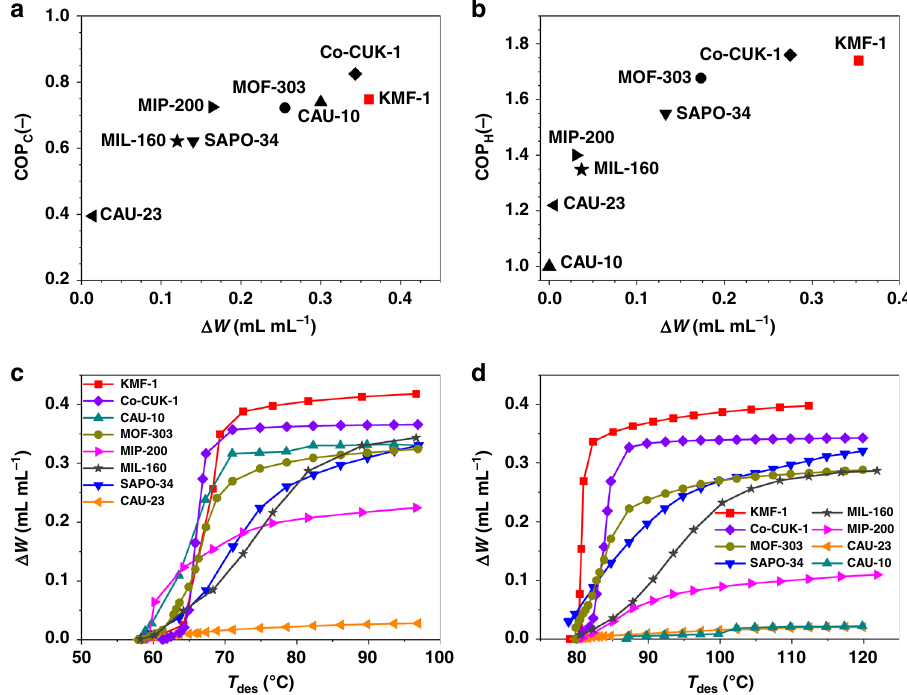
Fig. 4 Water-sorption performances of KMF-1 and benchmark adsorbents. a Coef fi cient of performance for cooling (COP C ) versus volumetric working capacity ( Δ W ) de fi ned as the volume of liquid water per volume of dry adsorbent; these thermodynamic calculations were performed for the standard AC conditions ( T ev = 5 °C, T ads = 30 °C, T cond = 30 °C, and T des = 70 °C). b Coef fi cient of performance for heating (COP H ) versus volumetric working capacity ( Δ W ) de fi ned as the volume of liquid water per volume of dry adsorbent; these thermodynamics calculations were performed for standard AHP conditions ( T ev = 15 °C, T ads = 45 °C, T cond = 30 °C, and T des = 85 °C). c Plots of volumetric working capacity ( Δ W ) as a function of desorption temperature ( T des ) for AC conditions ( T ev = 5 °C, T ads = 30 °C, and T cond = 30 °C). d Plots of volumetric working capacity ( Δ W ) as a function of desorption temperature ( T des ) for AHP conditions ( T ev = 15 °C, T ads = 45 °C, and T cond = 30